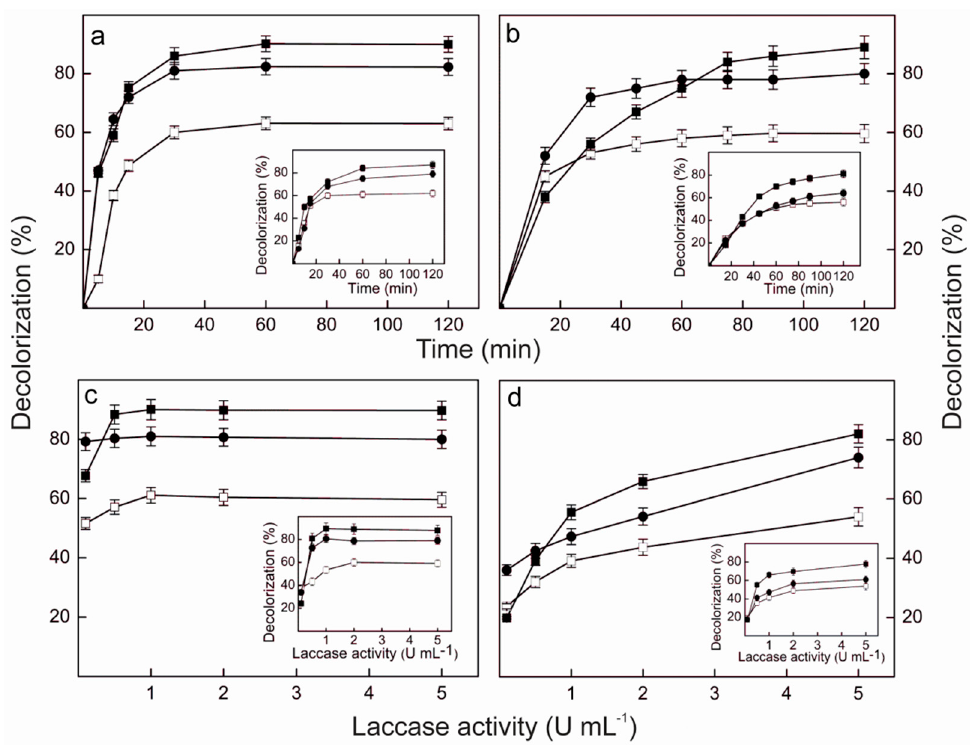
Figure 5. Effects of the reaction time and the laccase activity load on the decolorization of BPB, RB4 and RBBR by the pure Lacps1 ( a , c ), or the crude culture extract from P. sanguineus RP15 ( b , d ), at 40 °C. Dyes final concentrations were 100 mg·L − 1 (RBBR and RB4) or 25 mg·L − 1 (BPB), and the reactions were carried out in McIlvaine buffer, pH 4.5. ( a , b ). The enzymatic load was 5 U·mL − 1 ( c , d ); the reaction time was 120 min. Insets: Effects of the reaction time ( a , b ), and the laccase activity load ( c , d ), on dye decolorization by the crude extract ( b , d ), or the pure Lacps1 ( a , c ), at 25 °C. Data are presented as means ± SD from triplicate experiments ( n = 3) performed with three separate preparations of crude extract or pure Lacps1 (error bars are not evident, as they lie within the area of the symbol). Symbols: BPB ( ), RBBR ( ) and RB4 ( ).